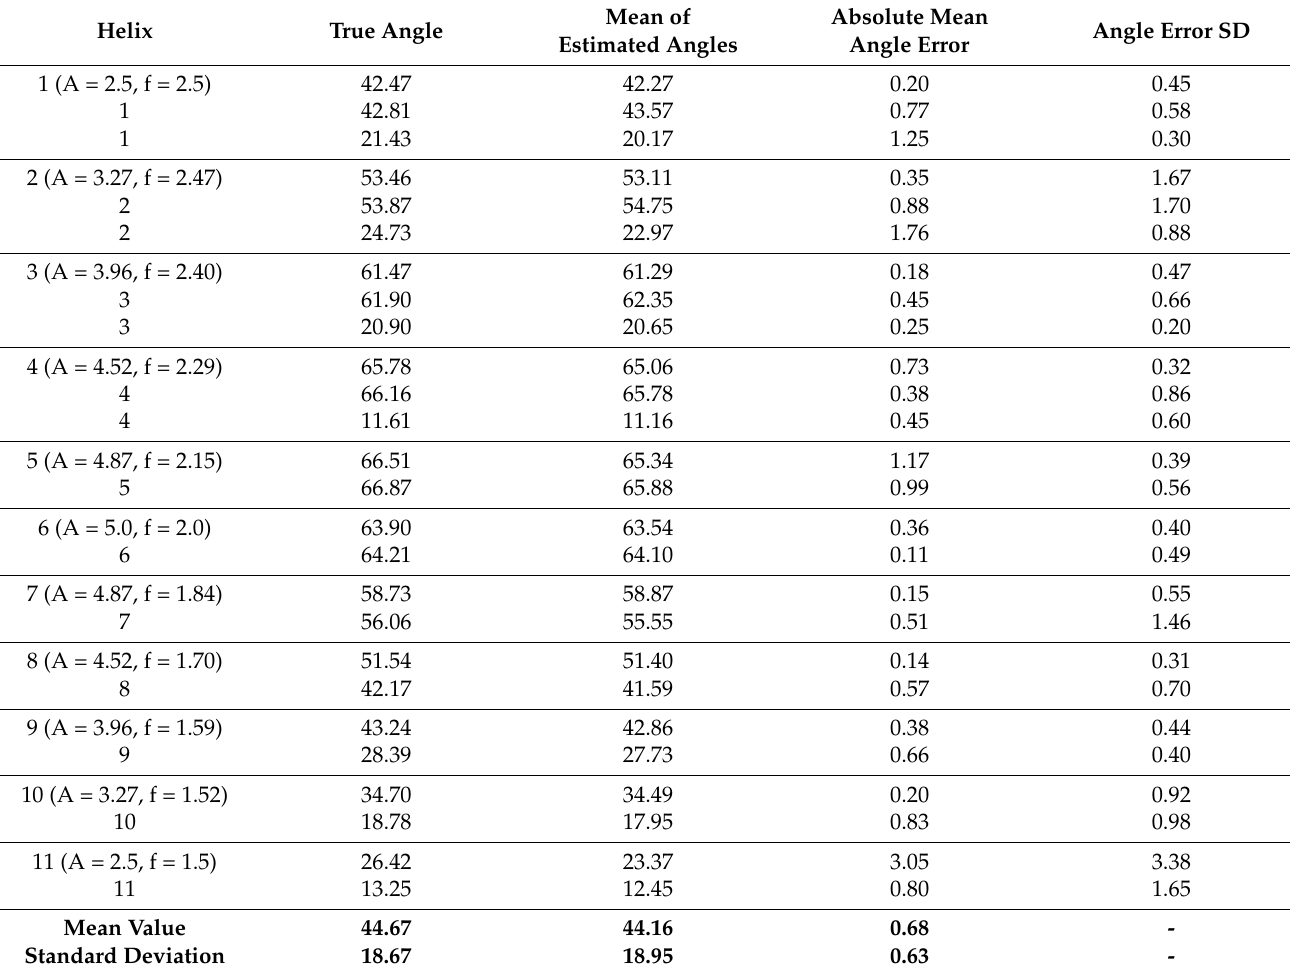
Table 2. Montecarlo scenario (3000 repetitions) helixes modelling spine deformations during movement: Assessed Absolute Mean Angle Error and SD simulating marker-misplacement error along the longitudinal direction.